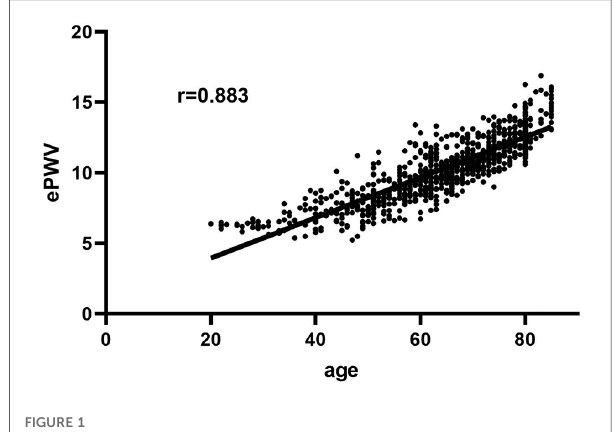
FIGURE 1 Correlations between age and ePWV.